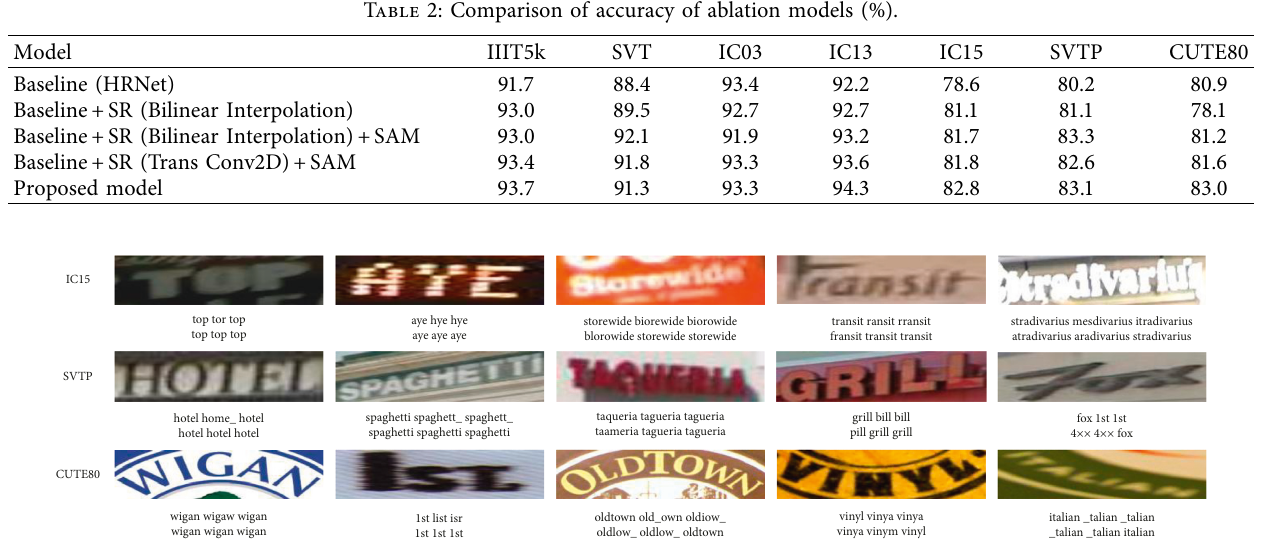
Figure 6: Qualitative comparison of recognition